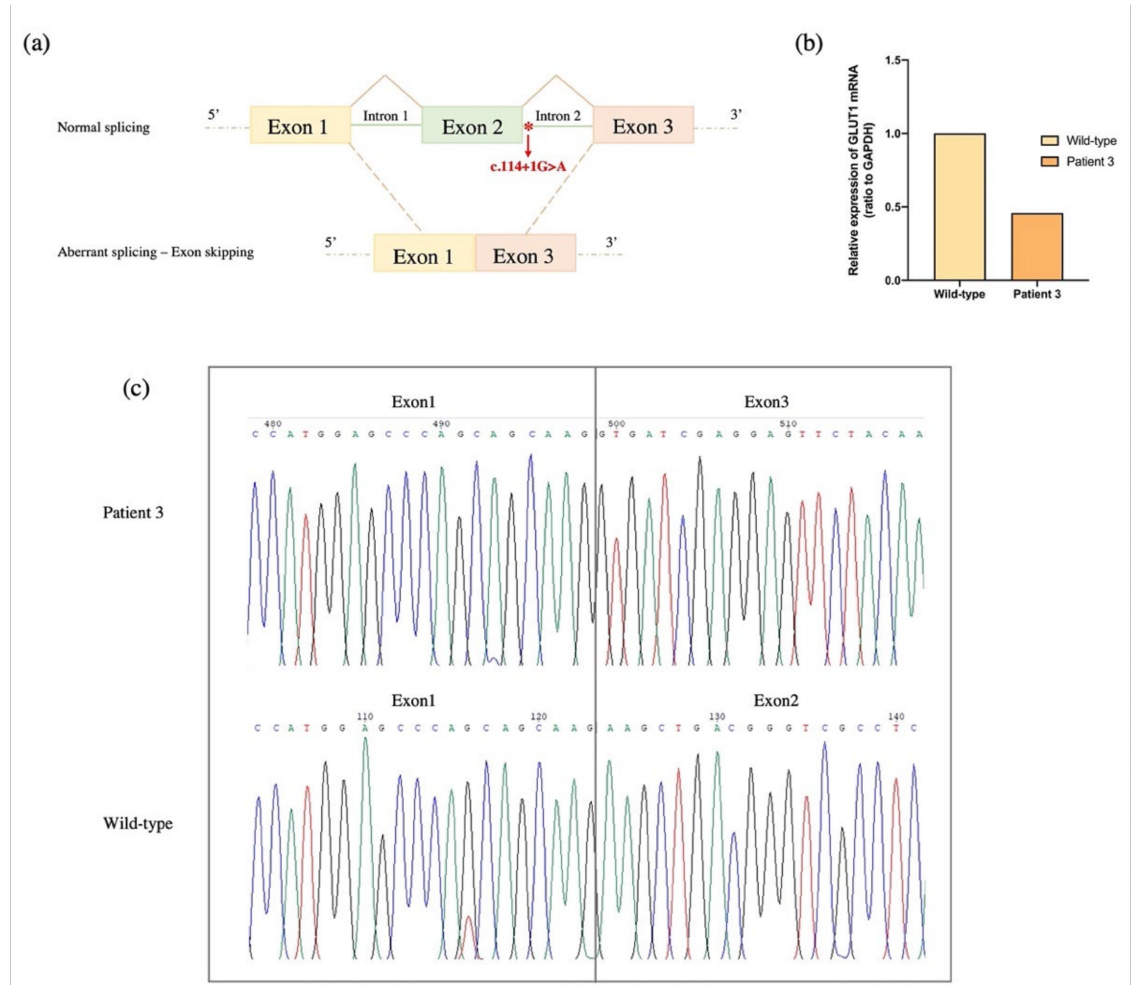
Figure 3. ( a ) Schematic illustration of normal (above) and aberrant splicing (bottom), which results in exon 2 skipping. The red asterisk indicates the novel heterozygous de novo c.114+1G > A vari- ant in intron 2. ( b ) Relative expression analysis of GLUT1 alternative isoform by RT-qPCR in the patient 3. GLUT1 expression data are normalized on GAPDH expression levels. ( c ) Sequence electro- pherograms showing the GLUT1 transcript with skipping of exon 2, resulting from the identified c.114+1G > A mutation, in patient 3 (above). As expected, the full-length GLUT1 transcript was identified in wild-type GLUT1